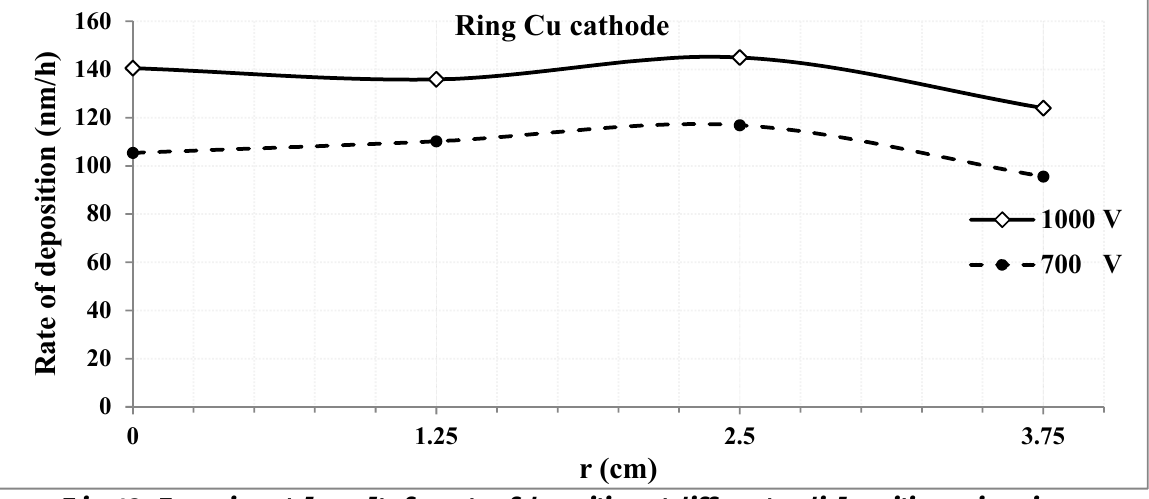
Fig. 13: Experimental results for rate of deposition at different radial position using ring cathode at -700 and -1000 volt applied voltage. Table 4: Comparison between simulation and experimental results for deposition rate (nm/h) for disc and ring cathode at -700 and -1000 V. Simulation results (disc